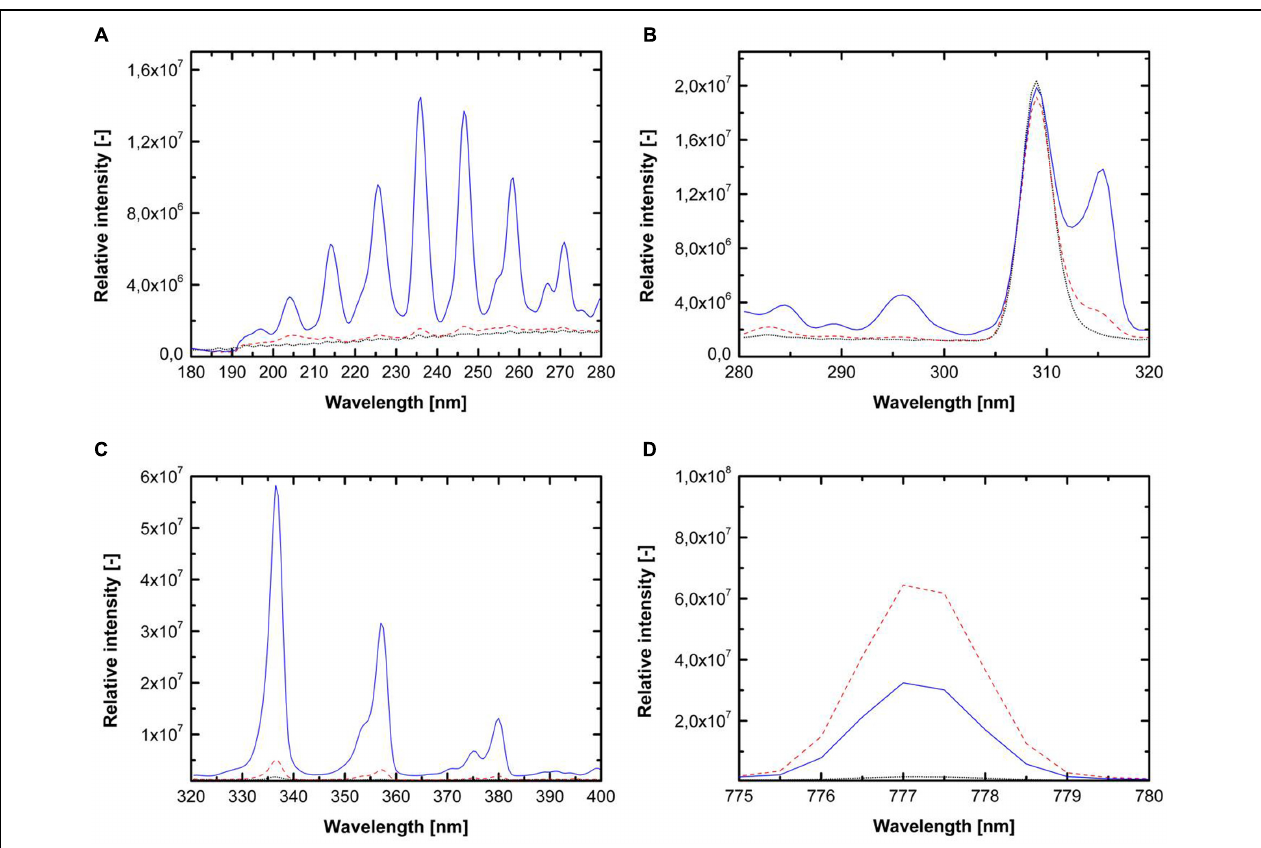
FIGURE 1 | Emission spectra for pure argon (dotted black line), argon + 0.135% vol. oxygen (dashed red line) and argon + 0.135% vol. oxygen + 0.2% vol. nitrogen (solid blue line) for wavelength from (A) 180–280 nm (UV-C light), (B) 280–320 nm (UV-B light), (C) 320–400 nm (UV-A light), and (D) 775–780 nm (atomic oxygen